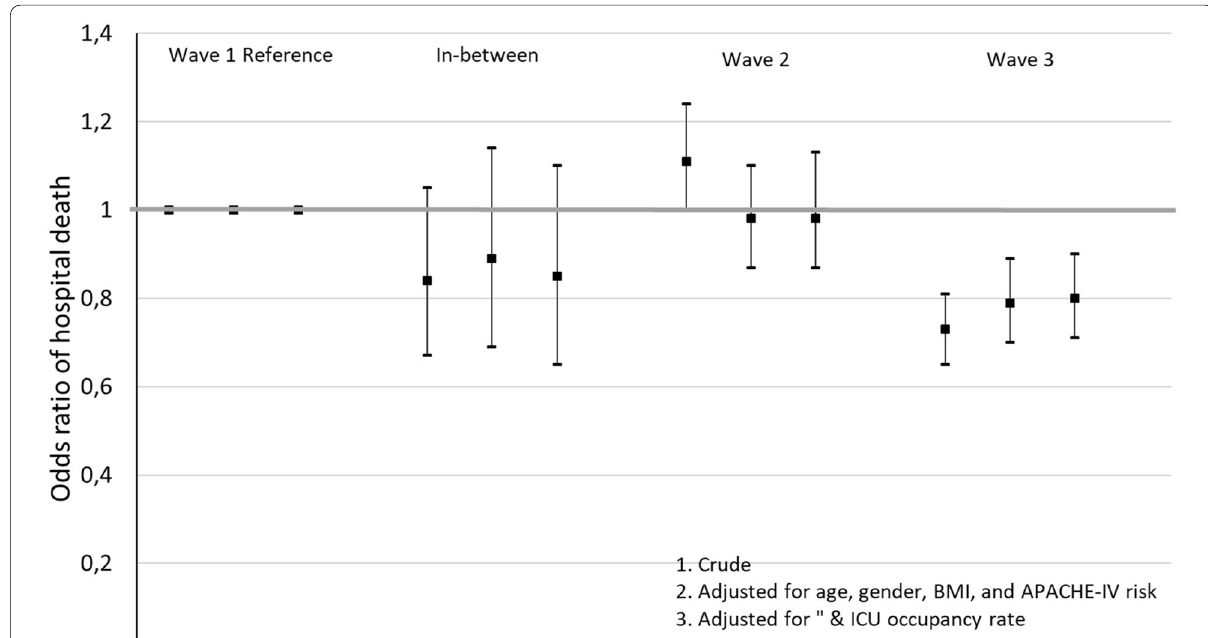
Fig. 2 Crude and adjusted logistic regression showing Odds ratios of hospital death during Wave 2 and Wave 3, and the period in‑between compared to Wave 1 (see Additional file 1: Table S2). Wave 1, February, 2020–May 24, 2020. Period in‑between, May 25, 2020–October 4, 2020. Wave